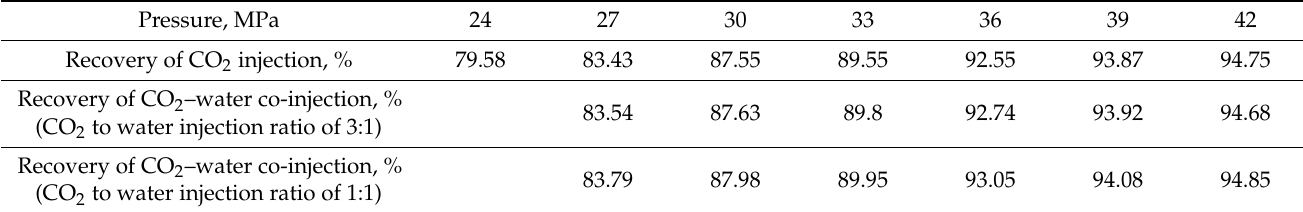
Table 9. Crude oil recovery at different pressures.